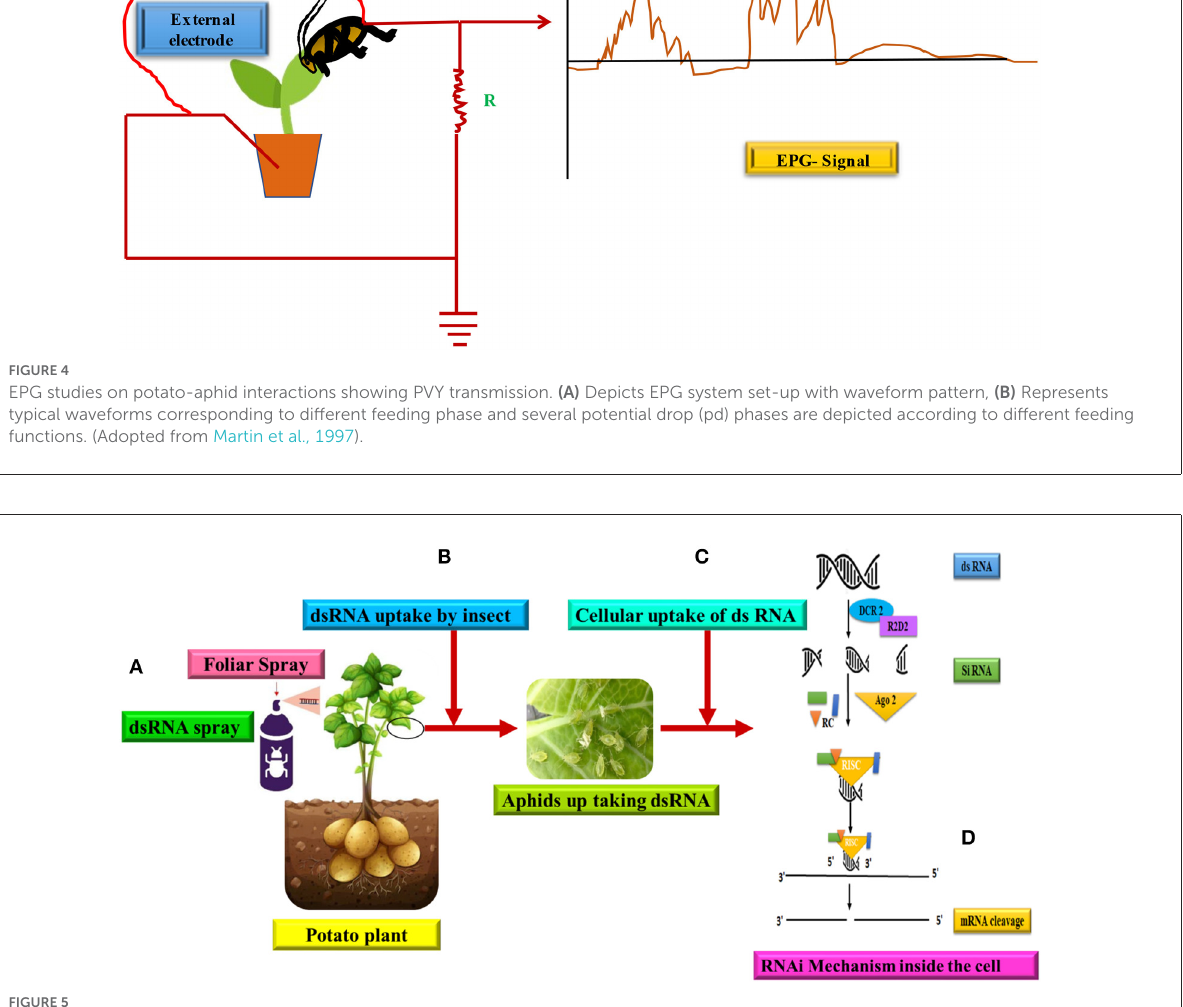
FIGURE5 RNAi mediated gene silencing and direct dsRNA uptake for management of PVY. (A) Foliar spray of artificial exogenous dsRNA to the potato plant, (B) Piercing-sucking stylets acquire the virus from the phloem tissues of the plant, (C) Uptake of dsRNA to the cells of aphid, (D) The cellular RNAi mechanism of gene silencing in insects is illustrated. The RNAi molecular mechanism began in the cell with the Dicer 2 (Dcr2) enzyme cleaving dsRNA into short 21-24 nucleotide small interfering RNA (siRNA) duplexes. Following that, siRNAs are bound by Argonaute 2 (Ago2) proteins, which assemble the siRNA duplexes into the RNA-induced silencing complex (RISC), a multiprotein-siRNA structure. The RISC then mediates the cleavage of mRNA transcripts complementary to the integrated guide strand, thereby silencing the target gene and blocking protein translation (Modified from Cooper et al.,